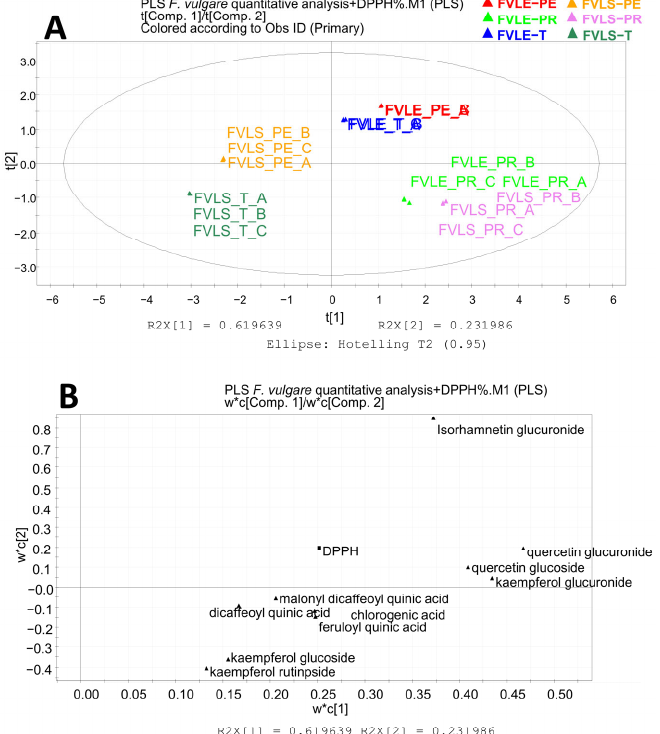
Figure 3. Partial least square analysis: quantitative results related to the antioxidant activity (DPPH) of the ethanolic extracts of F. vulgare waste. ( A ) Score scatter plot; ( B ) loading plot. FVLE-T, Foeniculum vulgare leaf Tiziano variety; FVLE-PE, Foeniculum vulgare leaf Pegaso variety; FVLE-PR, Foeniculum vulgare leaf Preludio variety. A PLS analysis with TEAC inhibition as the Y-block is represented by Figure 5. The first component explains the 62% of variance, while the second explains the 22% of vari- ance. The results of the score scatter plot are the same as obtained with the DPPH, thus confirming that Preludio leaves and little stems are the parts of fennel waste with the greatest antioxidant activity. Again, the isorhamnetin 3-O-glucuronide is an outlier and was eliminated. The variables that are responsible for the antioxidant power are con- firmed as quercetin 3-O-glucuronide, quercetin 3-O-glucoside, kaempferol 3-O-glucu- ronide, and also malonyl dicaffeoylquinic acid (Figure 4B).